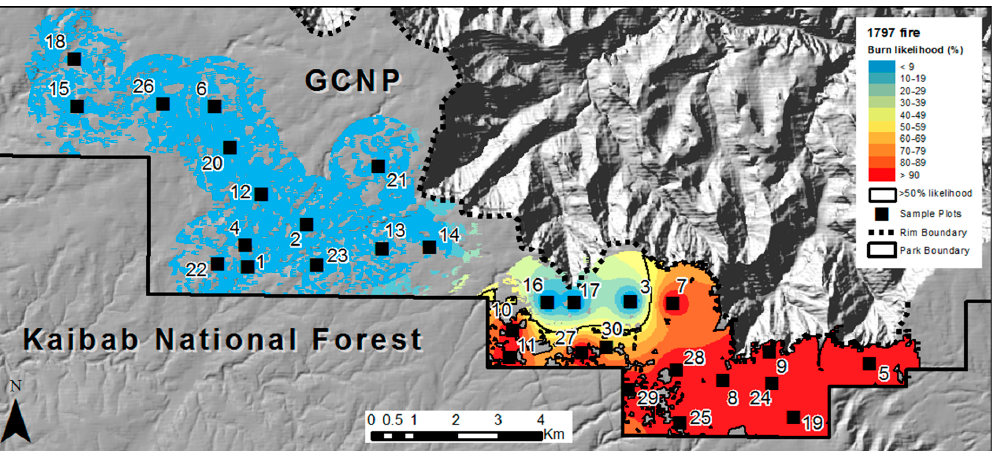
Figure 7. An example fire-year map for an 1829 fire on the south rim of Grand Canyon, Arizona. The reconstructed fire area was derived using inverse distance weighting based on plot records that showed where the fire did and did not burn. Reprinted from ([52] Figure S1) with permission from John Wiley and Sons.